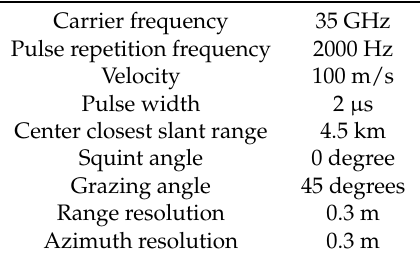
Table 5. Ka-Band simulation